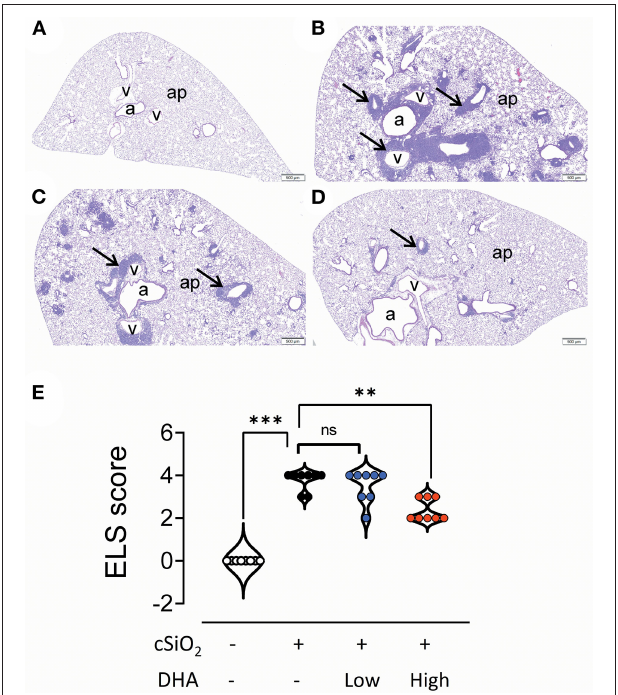
FIGURE 6 | DHA-containing diets reduce CD3 + T cell infiltration in cSiO 2 -instilled mice. Light photomicrographs of lung tissue sections immunohistochemically stained for CD3 + T cells (arrows) from mice fed control diet and intranasally instilled with saline vehicle Veh/CON, A ), fed control diet and intranasally instilled with cSiO 2 (cSiO 2 /CON, B ), fed 0.4 % DHA diet starting one week after the end of the intranasal cSiO 2 instillations (cSiO 2 /low DHA, C ), or fed the 1.0% DHA diet starting one week after the end of the intranasal cSiO 2 instillations (cSiO 2 /high DHA, D ). Marked accumulation of perivascular and peribronchiolar CD3 + T cells (arrows) in lung of cSiO 2 /CON mouse. Moderate, minimal and no accumulations of CD3 + T cells around blood vessels (v) and bronchioles (b) in the lungs of cSiO 2 /low DHA (C) , cSiO 2 /high DHA (D) , and Veh/CON (A) mice, respectively. a, alveolar parenchyma. (E) depicts percentage of CD3 + lung tissue. Statistical comparisons were performed as described in the Methods section. *** p ≤ 0.001, ** p ≤ 0.01, * p ≤ 0.05, ns = not significant. with Dunnett’s post-hoc test or unpaired Student’s t -test. Data were presented as mean ± standard error of the mean